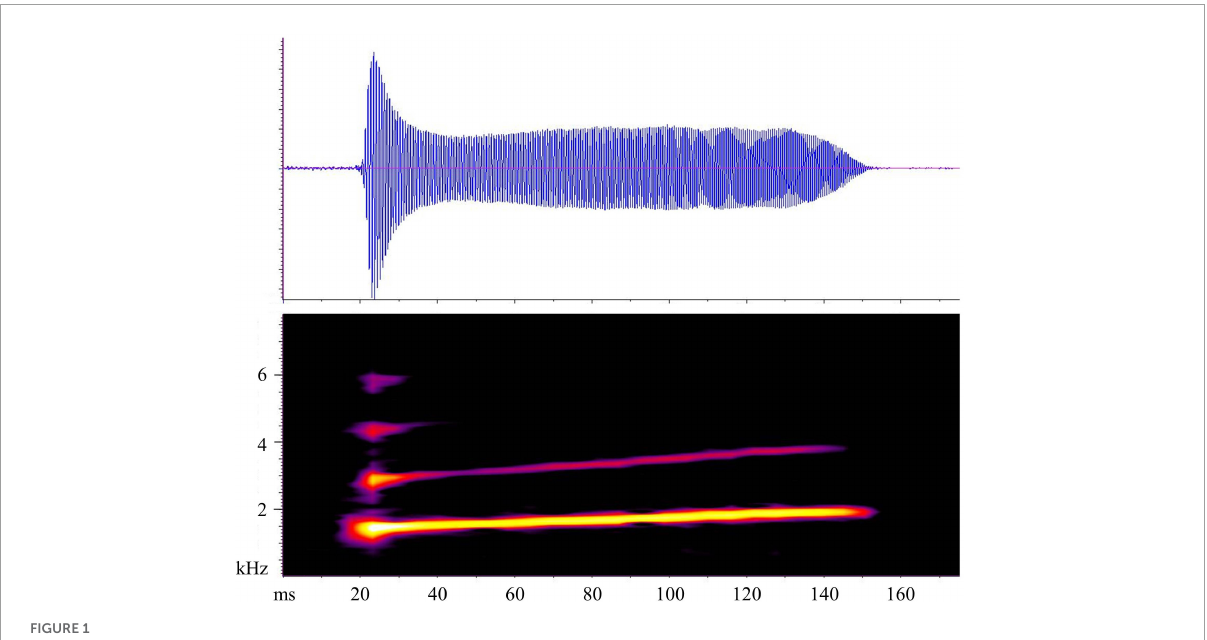
FIGURE1 Graphical representation of one mating call of L. bufonius from Corrientes (Argentina) analyzed in this study. The upper part represents the oscillogram, and the lower part represents the audiospectrogram.